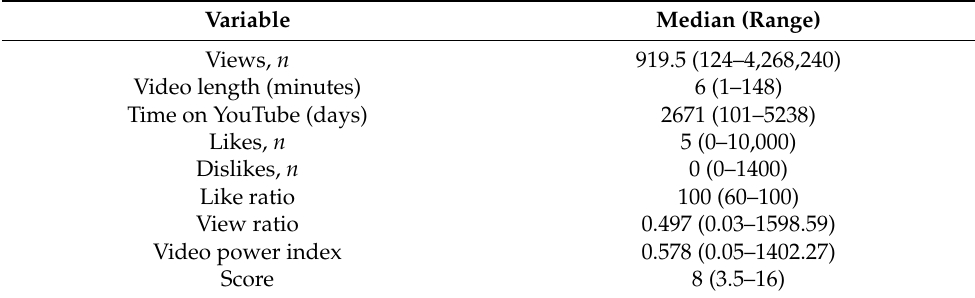
Table 2. Descriptive features of robotic myomectomy-related YouTube videos ( n =